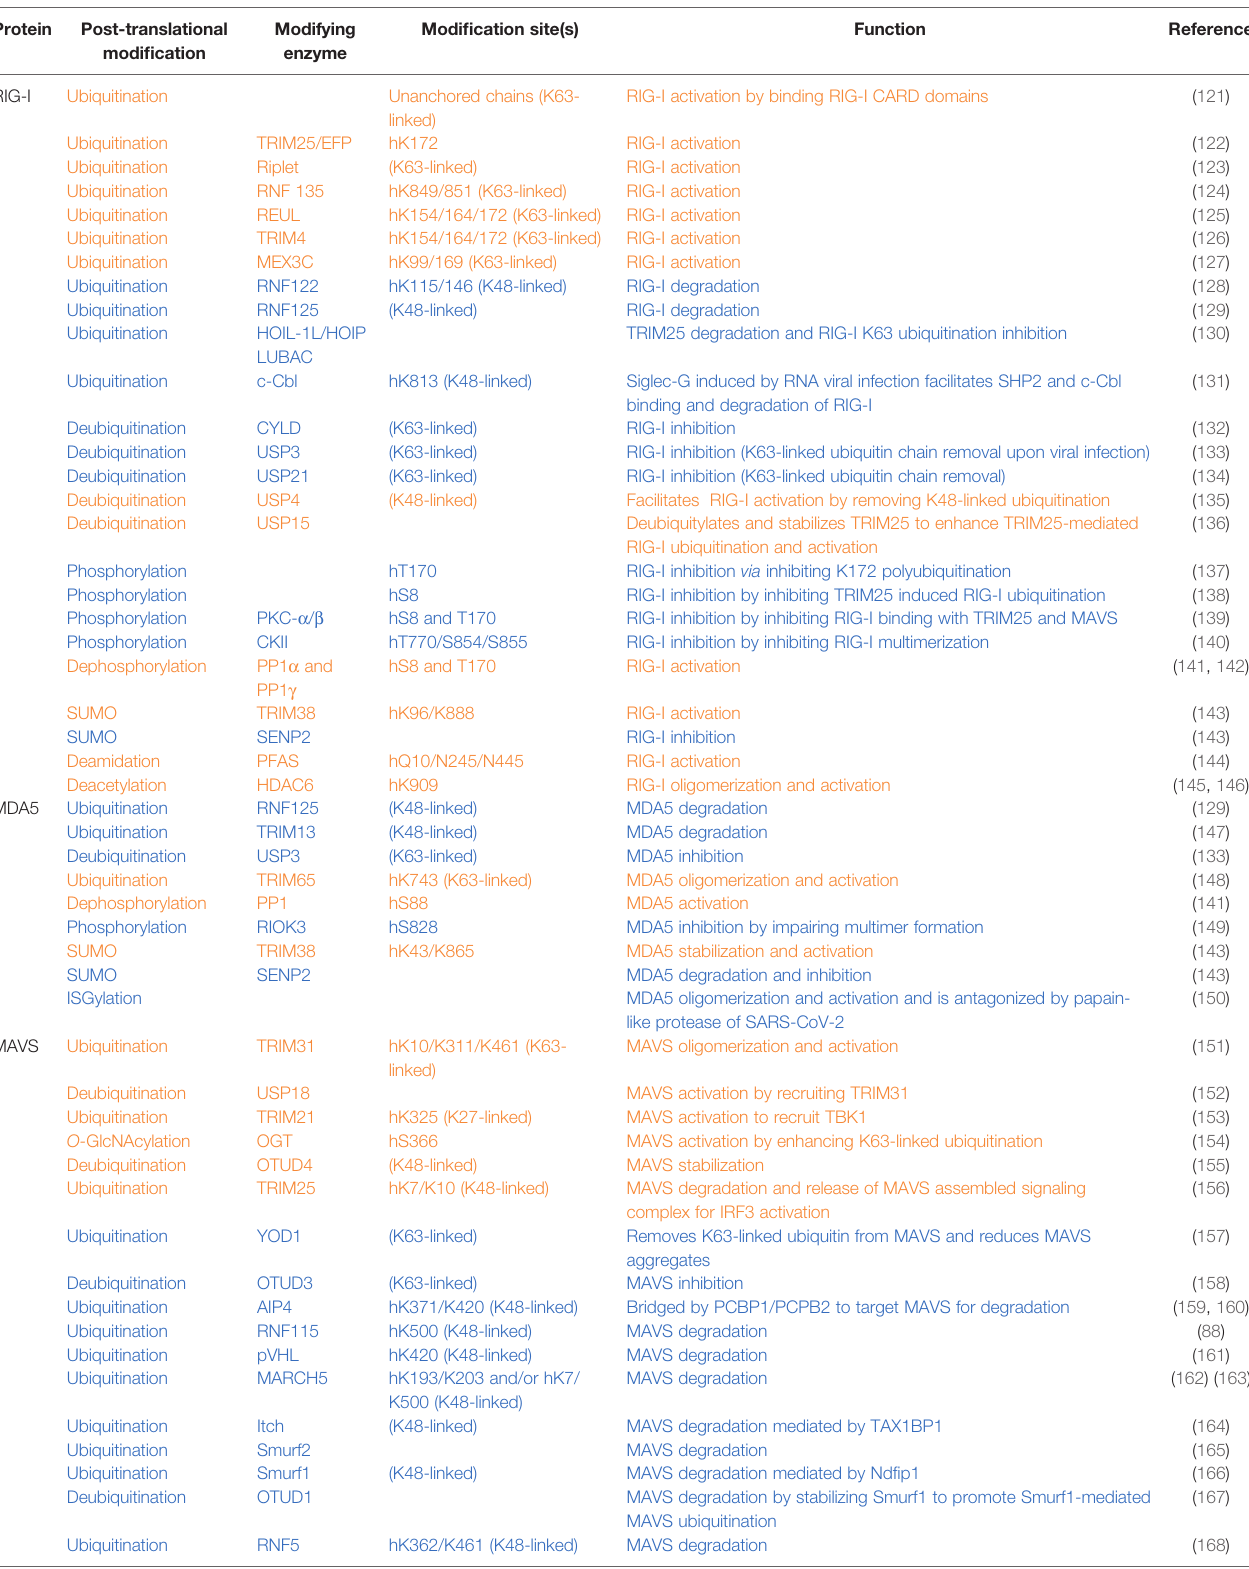
TABLE 2 | Post-translational modi fi cations of proteins in cytosolic RNA sensing signaling pathways. Protein Post-translational modi fi